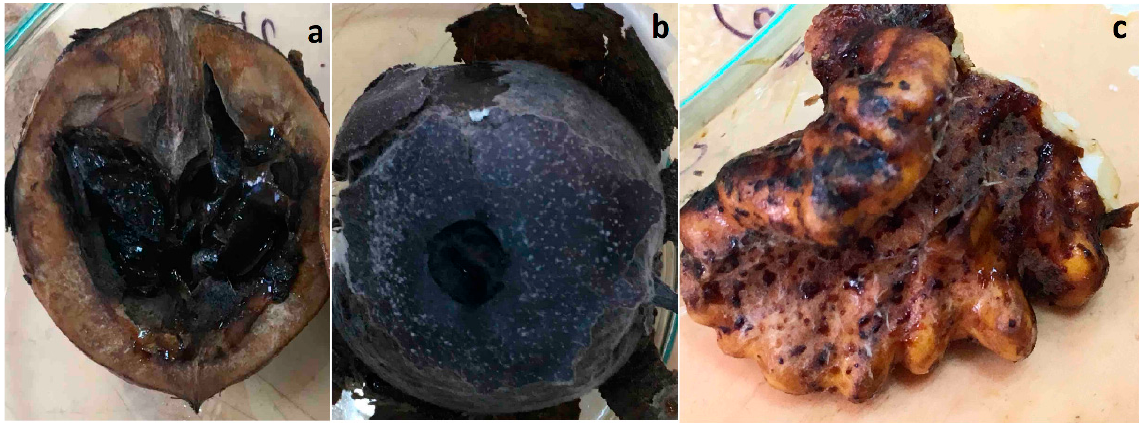
Figure 7. Examples of kernel ( a , c ) and husk ( b ) necrosis caused by Diaporthe eres symptomatic nut after the inoculation of the immature fruit with Diplodia seriata . The pictures were taken three weeks after the inoculation of a deliberately inflicted husk lesion with growing the mycelium of the pathogen taken from a PDA plate monoculture. Table 3. Average McKinney index (Imc%) [53] of Diaporthe eres Nitschke and Diplodia seriata De Notaris isolates on the green husk and kernel of English walnuts. Calculated from the results recorded three weeks after the inoculation of a deliberately inflicted wound with life mycelia of the pathogens.